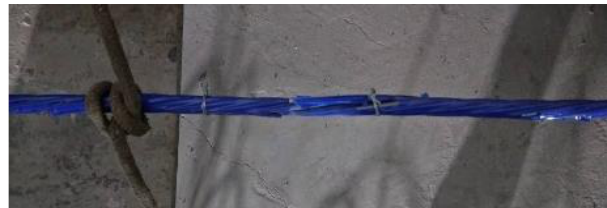
Figure 4. Schematic picture of the tensile load application process.